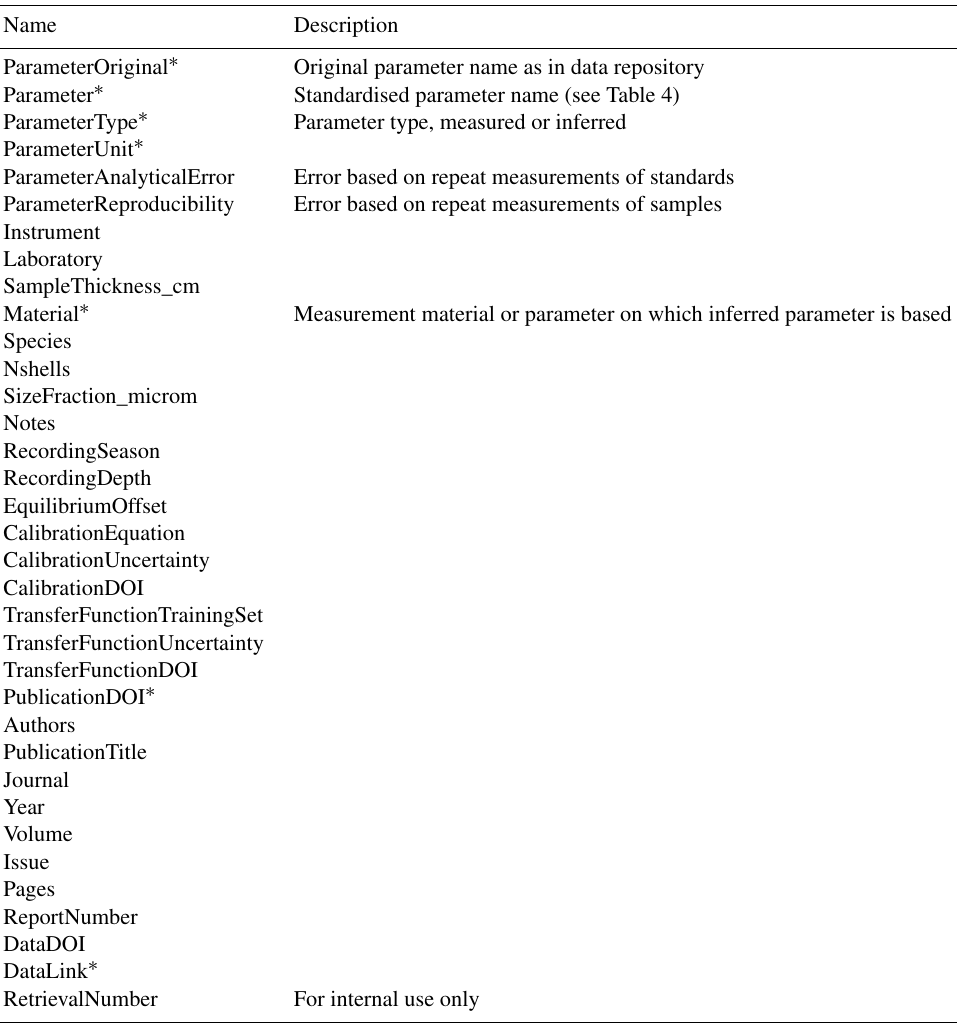
Table 2. Metadata